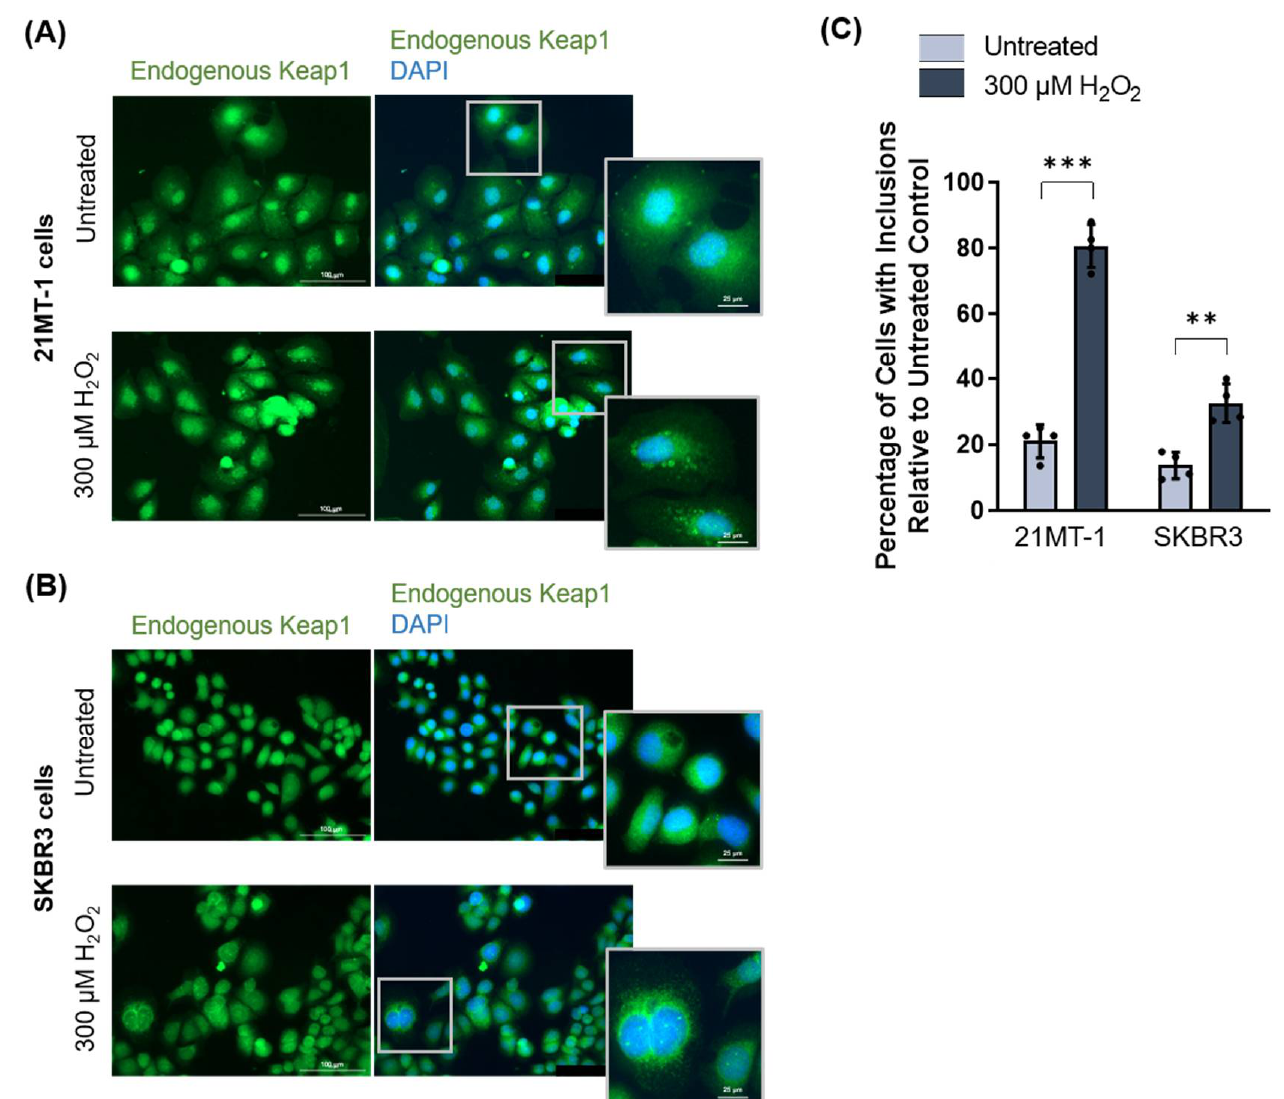
Figure 7. Keap1 forms oxidative stress-induced inclusions in breast cancer cell lines. ( A , B ) Endoge- nous Keap1 expression in two breast cancer cell lines, 21MT-1 (A) and SKBR3 (B), treated with 300 µM H 2 O 2 for 3 h, visualized by immunofluorescence microscopy. ( C ) Quantification of Keap1 inclu- sions following hydrogen peroxide treatment in ( A , B ). Means derived from three biological repli- cates were used during the analysis. Means were analyzed using one-way ANOVA followed by Tukey’s post hoc test. Data are expressed as mean ± SD. p < 0.05 was considered statistically signif- icant; ** p < 0.01, *** p < 0.001.